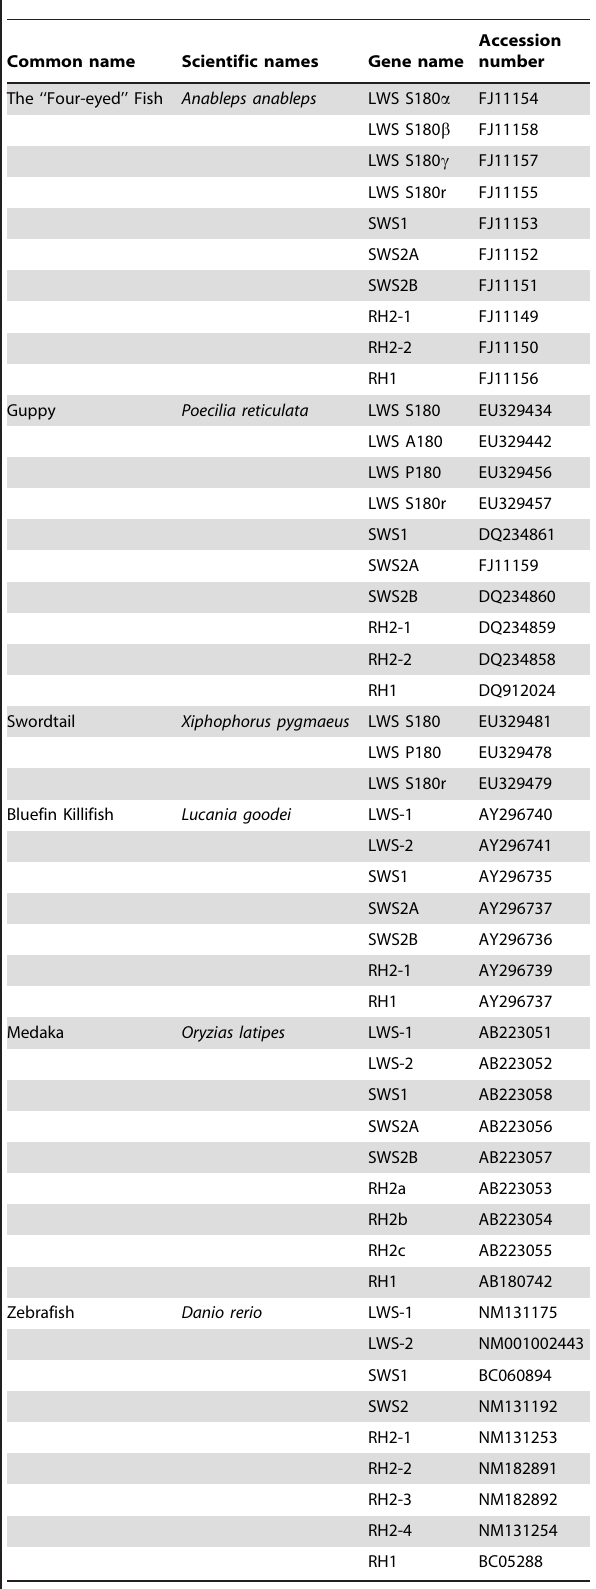
Table 3. Sequences used in phylogenetic